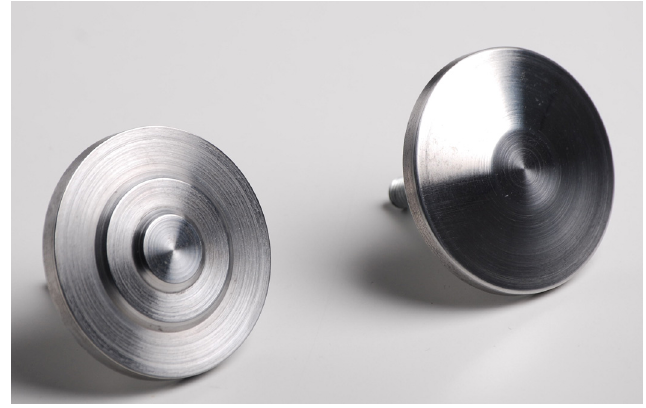
Figure 3: Prototypes of point